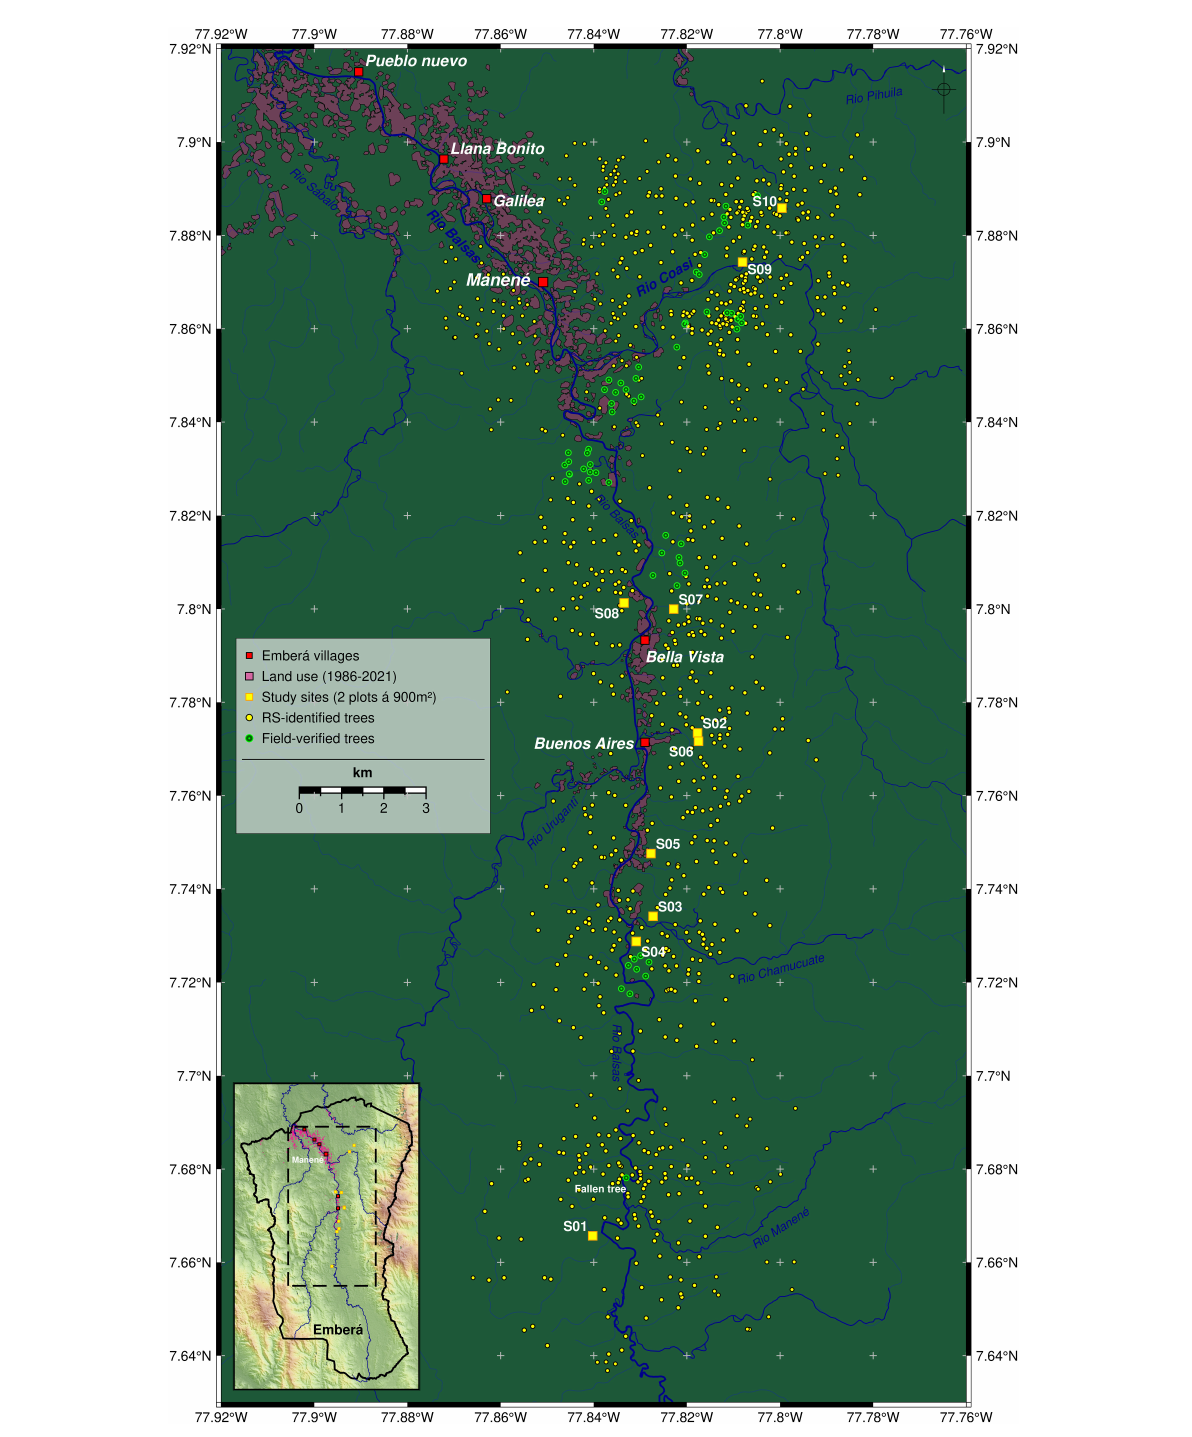
FIGURE2 Detailed map of the study area. Site locations (S1–S10) are shown as yellow squares. At each site two plots of 30 m*30m were surveyed. Further (potentially large) trees ( n = 1,080), that have been identified using remote sensing (RS), are shown as yellow dots. Field-verified RS trees ( n = 66) are shown as green dots. Red squares mark Emberá ( Tierras Colectivas del Río Balsas ) settlements. Major rivers are shown in blue. Recent past land use areas (1986–2021) are shown as semi-transparent pink polygons. Inset map shows map section (dashed line) within the border of the territory (black line) and colored hill shaded topography (NASA